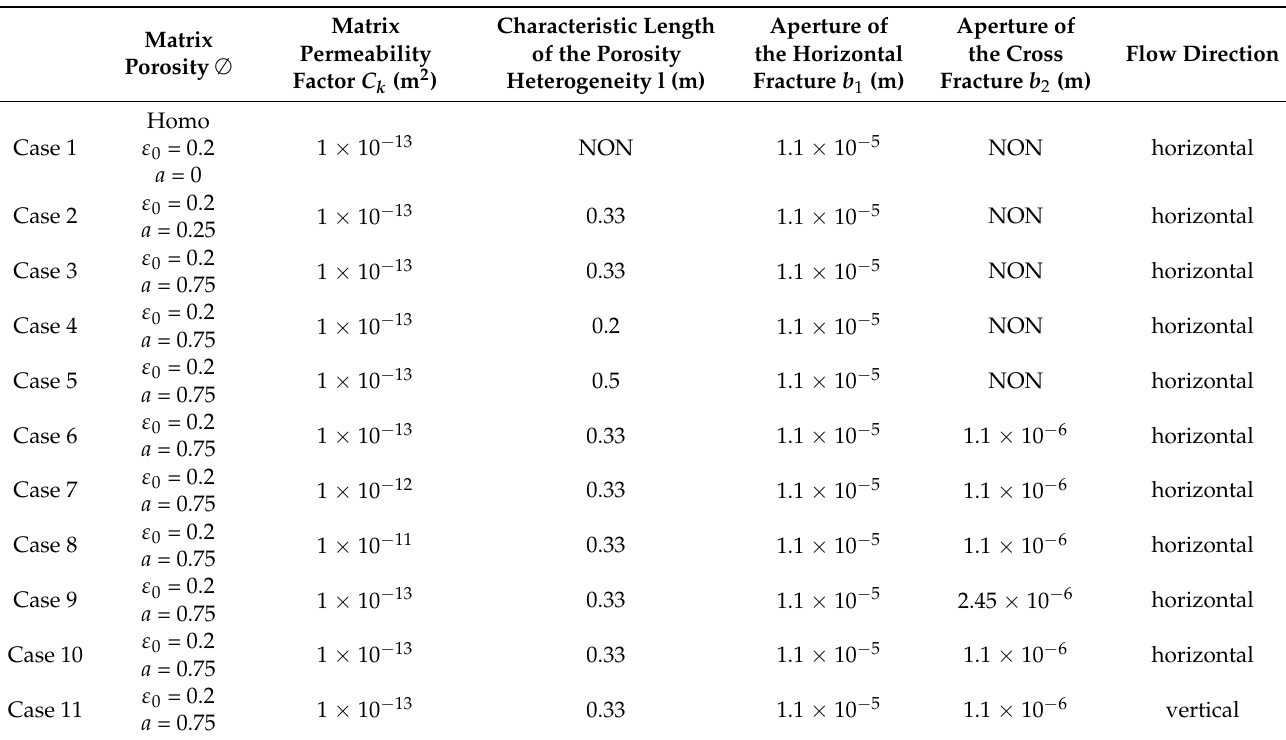
Table 1. Parameters of the simulation